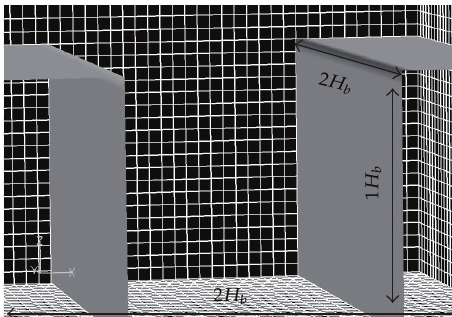
Figure 1: Analysis domain: the domain size of streamwise, span, and vertical directions is 2.0 H b , 2.0 H b , and 5.5 H b , respectively. H b refers to the cavity height.